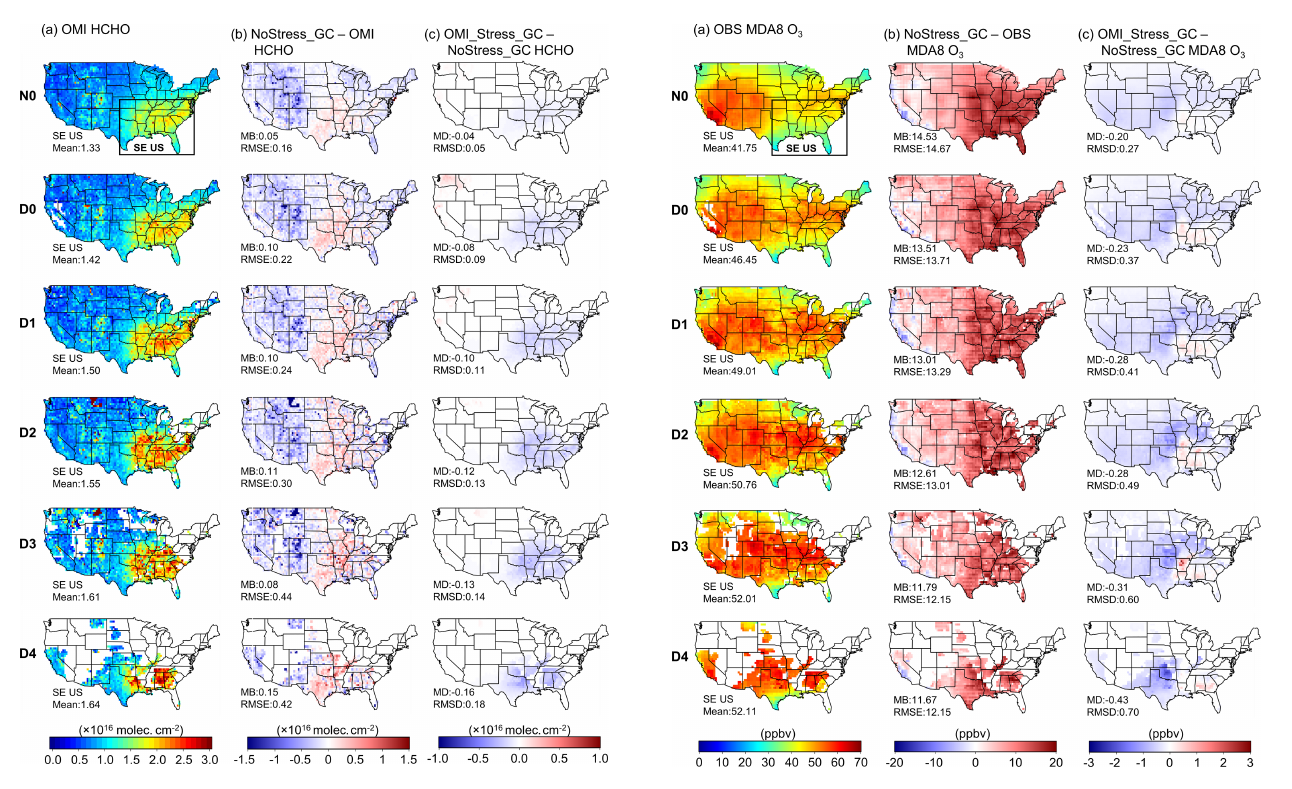
Figure 11. Same as Fig. 10 but for surface maximum daily 8h av- erage (MDA8) O 3